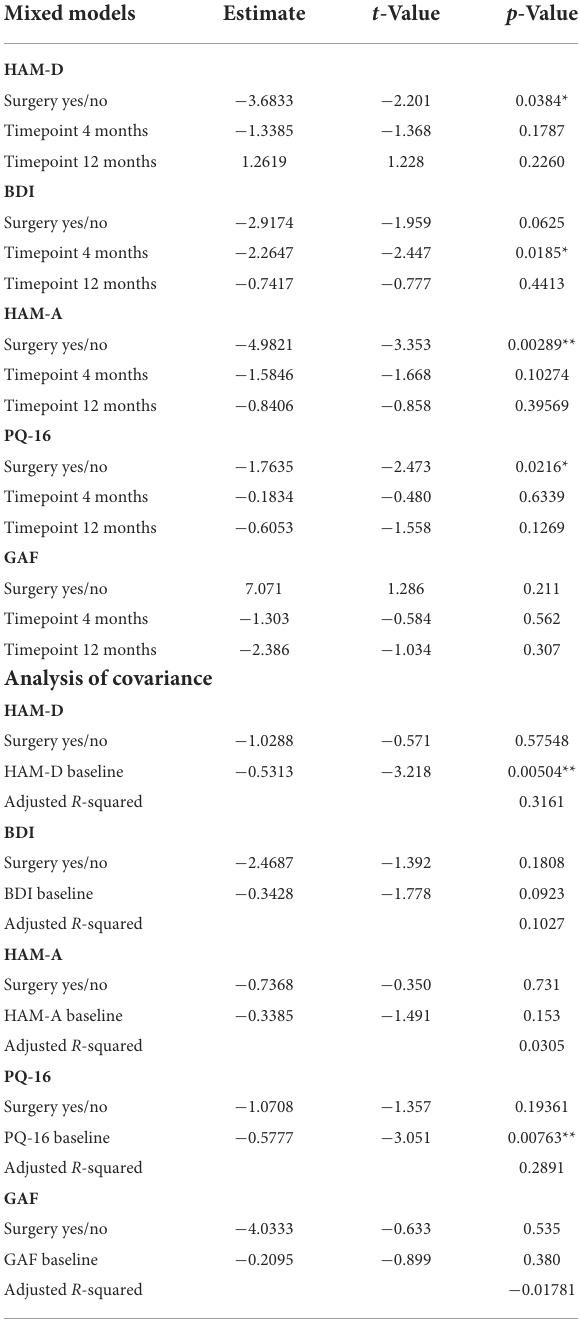
TABLE 3 Mixed model